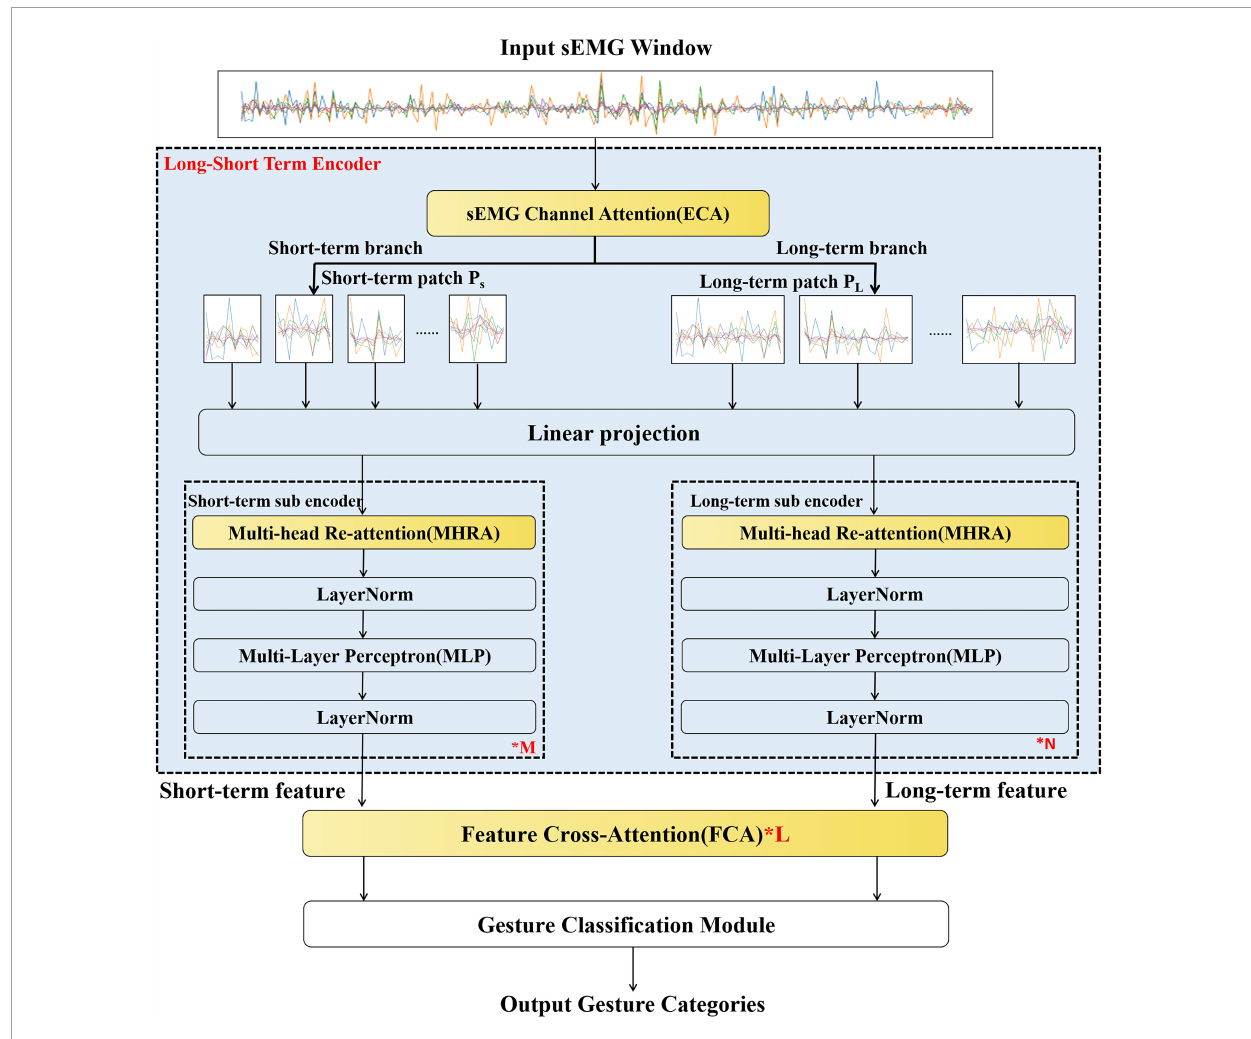
FIGURE3 The proposed LST-EMG-Net structure. Among them, the sEmg channel attention, multi-head re-attention and the feature cross-attention module (yellow module) are the contribution points of this manuscript.